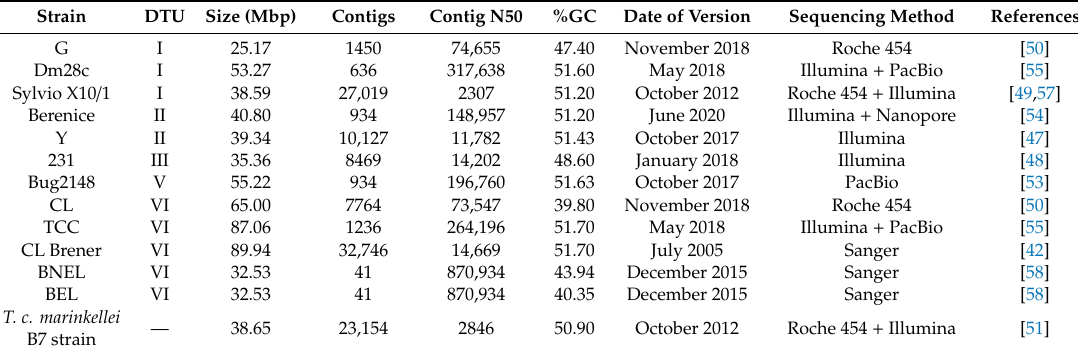
Table 1. Data of the most recent genomes of the best-studied strains of T. cruzi and the B7 strain of T. cruzi marinkellei . BNEL: CL Brener Non-Esmeraldo-like; BEL: CL Brener Esmeraldo-like; PacBio: Pacific Biosciences. Contig N50: is a statistic median such that the 50% of the whole assembly is contained in contigs equal to or larger than this value. Strain DTU Size (Mbp)